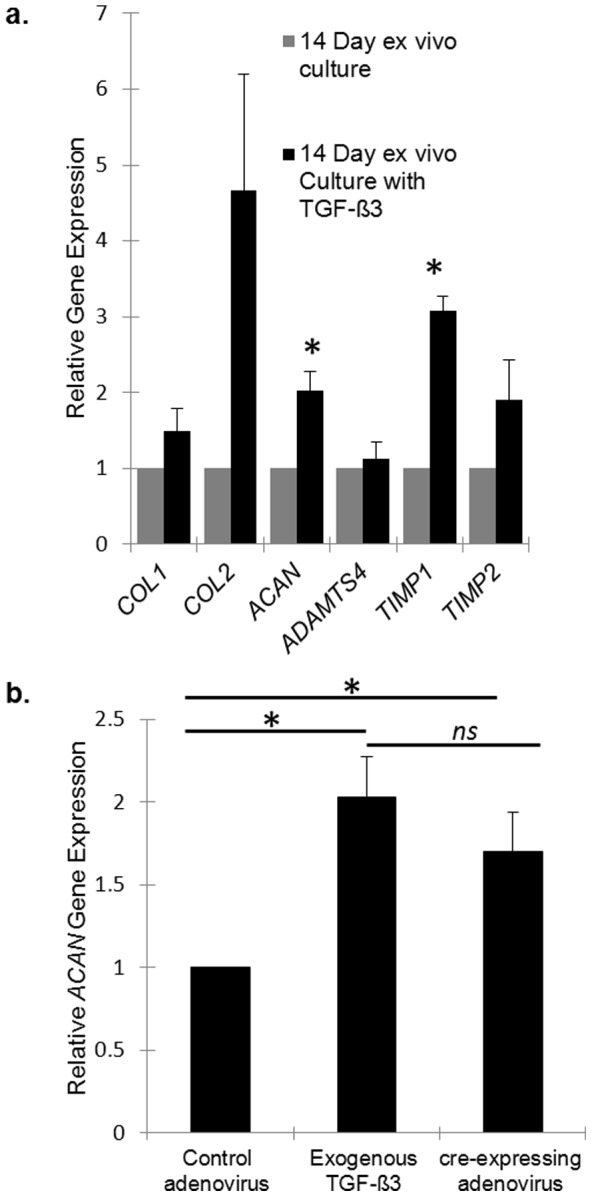
IVD explant response to TGF-ß.(a) Real-time PCR analysis of murine IVD explant gene expression response to stimulation with exogenously administered TGF-ß3 (10 ng/mL for 24 hours) demonstrates significant increase in the gene expressions of ACAN and TIMP1. Values are normalized to GAPDH. Results are presented relative to IVDs cultured without TGF-ß3 where the expression value was set to 1. Values are normalized to GAPDH. (b) Murine IVDs from TGFßR1fl/fl demonstrate significant upregulation in ACAN gene expression when cultured with cre-expressing adenovirus. Exogenous TGF-ß3 at 10 ng/mL for 24 hours was cultured with wild-type murine IVDs. Results are presented relative to IVDs cultured with control adenovirus where the expression value was set to 1. Values are normalized to GAPDH. * denotes statistical significance (p<0.05). ns denotes not statistically significant (p>0.05).